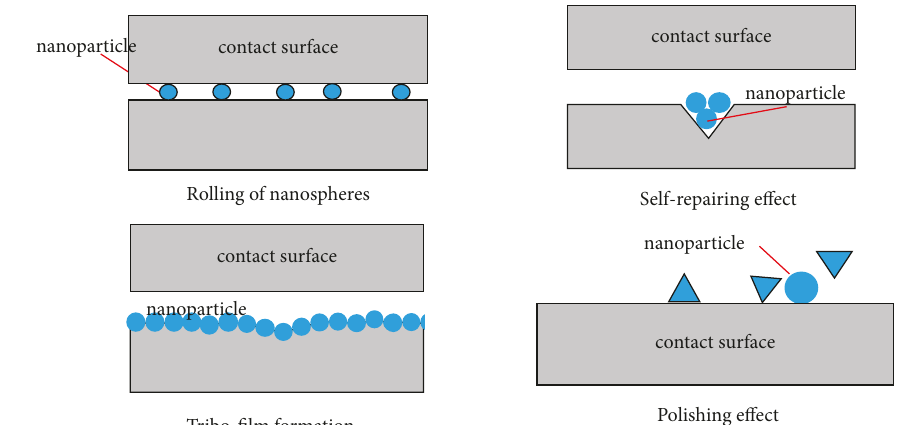
Figure 5: Four main mechanisms explaining the effectiveness of nanofluid.